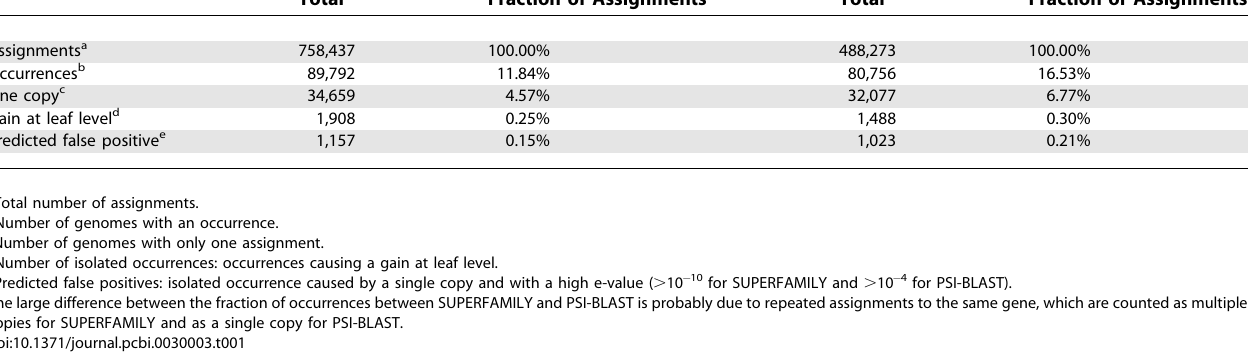
Table 1. Fraction of Assignments That Can Be Analysed by the Method Type